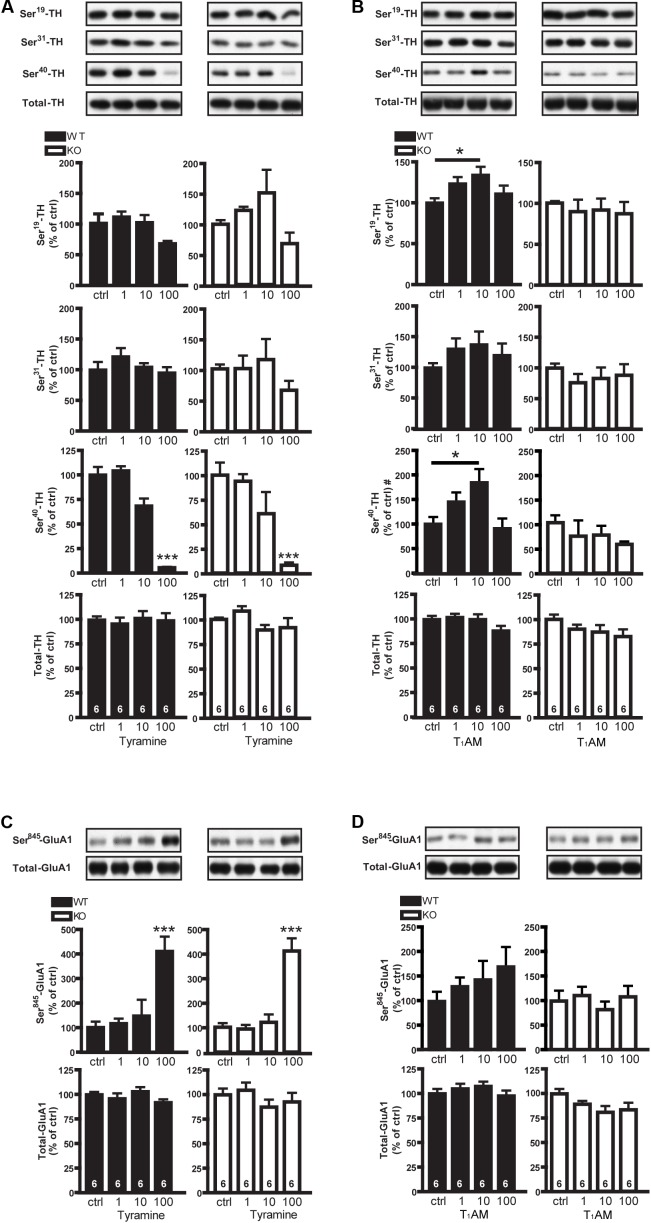
Effects of tyramine and T1AM on P-TH and P-GluA1 in striatal slices from WT and TAAR1 KO mice. Immunoblots against P-Ser19-TH, P-Ser31-TH, P-Ser40-TH, and total TH in control slices from TAAR1 WT and KO mice and in slices treated with tyramine (1, 10, 100 μM) (A) or T1AM (1, 10, 100 μM) (B). Histograms show the quantifications of P-Ser19-TH, P-Ser31-TH, P-Ser40-TH, and total TH levels, respectively. Immunoblots against P-Ser845-GluA1 and total GluA1 in control slices from WT and TAAR1 KO mice and in slices treated with tyramine (1, 10, 100 μM) (C), or with T1AM (1, 10, 100 μM) (D). Histograms show the quantifications of P-Ser845-GluA1 and total GluA1 levels, respectively. Data were normalized to total protein levels. The images are parts of the same gels. ∗p < 0.05; ∗∗∗p < 0.001; one-way ANOVA followed by Newman–Keuls test for pairwise comparisons. The number of individual replicates is indicated within each column, #denotes the number of individual replicates is 5 for each group of P-Ser40-TH.